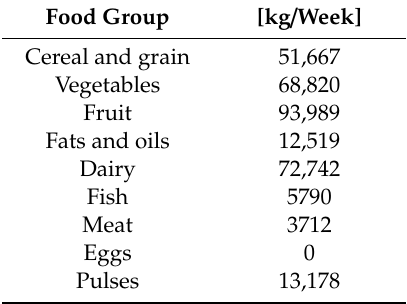
Table 6. Amount of